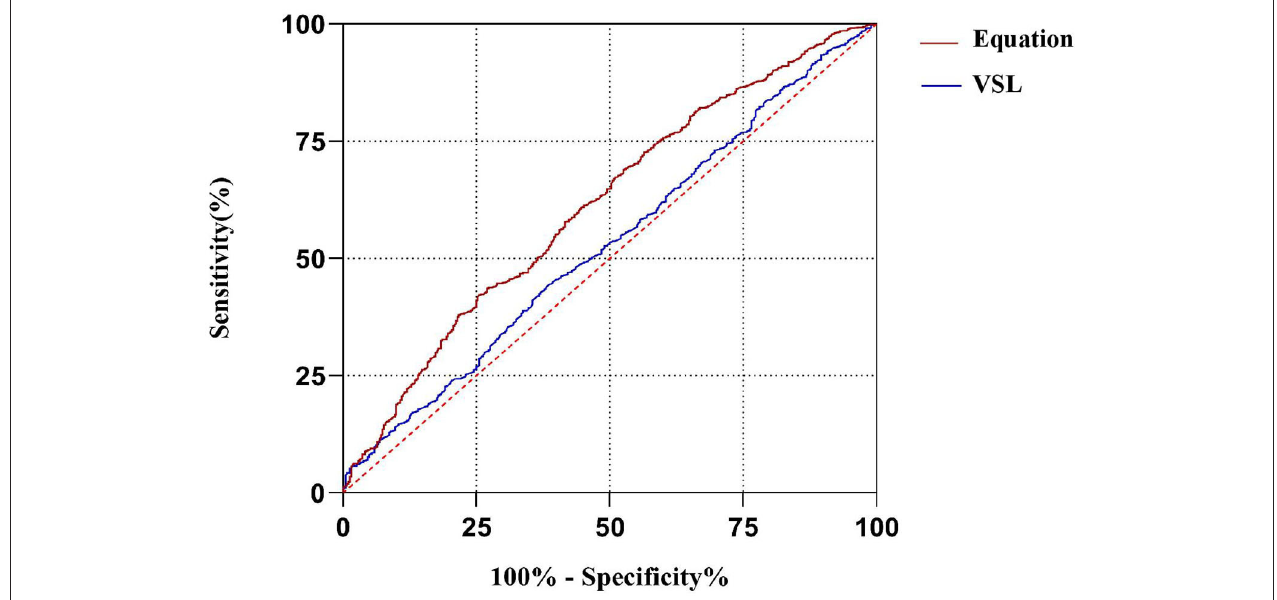
FIGURE 2 | ROC curves of the equation and the predicting factor VSL. The area under curve (AUC) of the equation is much larger than that of VSL, indicating that the equation has better capacity of prognostic